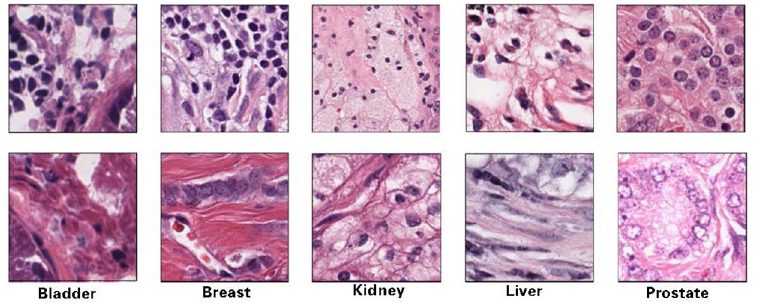
Fig 1. Sample HE stained images from different organs in MoNuSeg [9] dataset, in which high quality stained images are shown in the first row, and the second row contains low quality